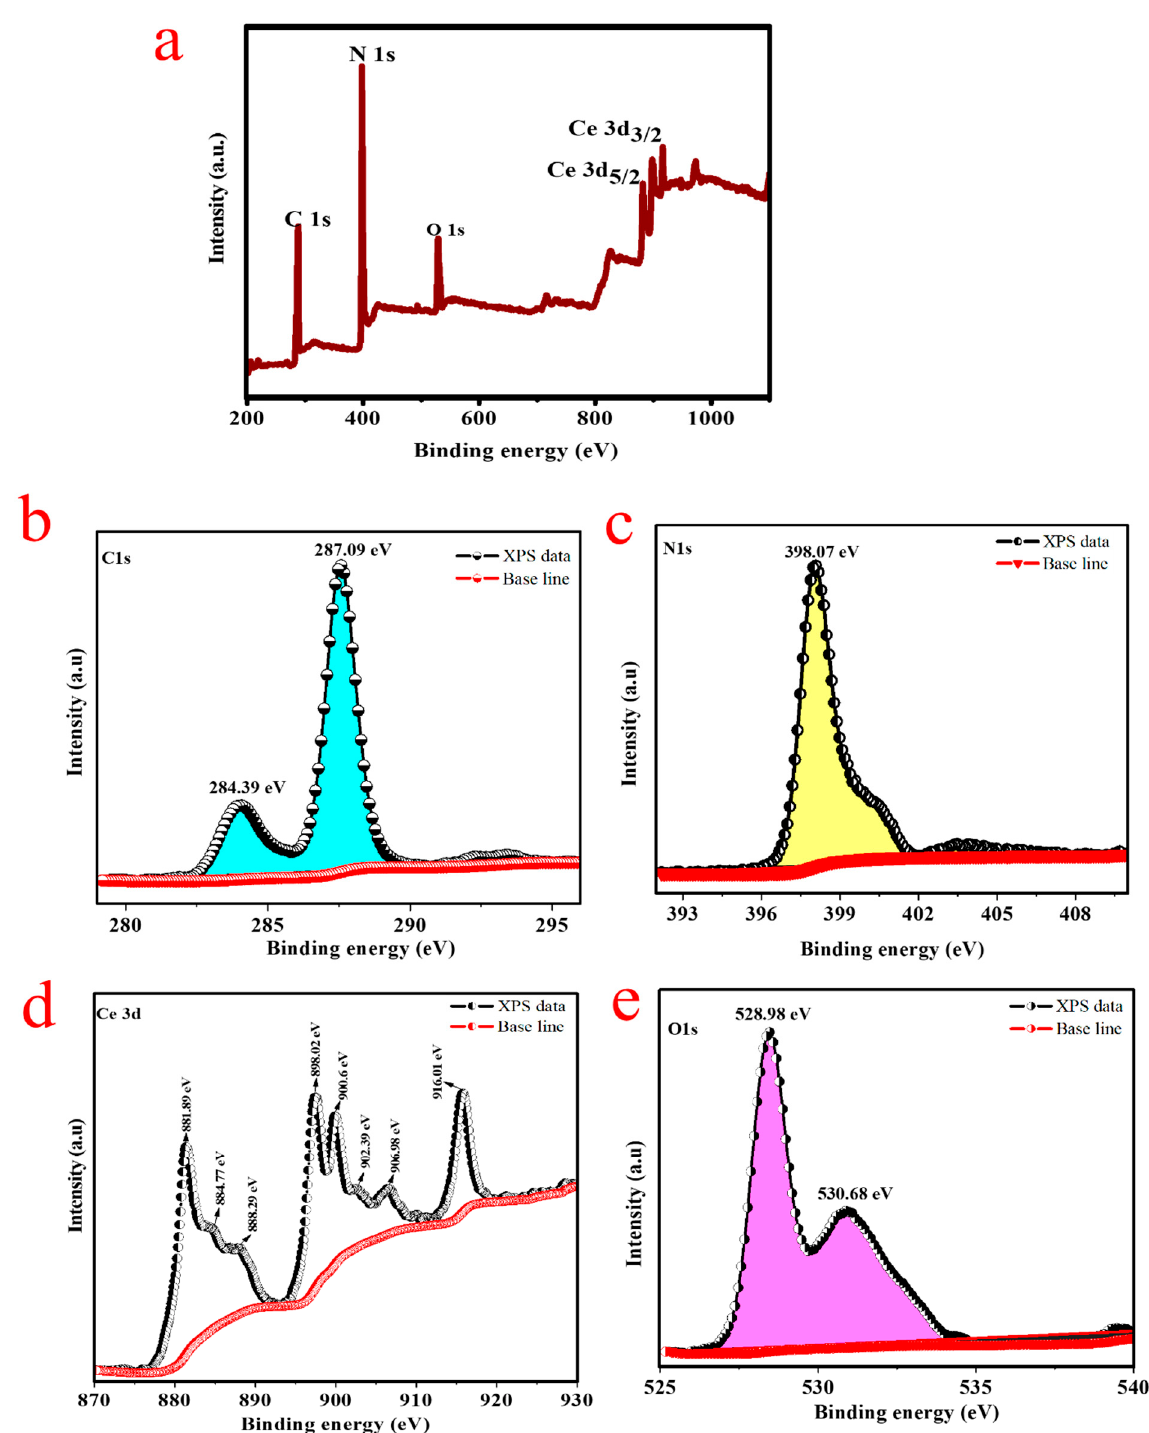
Figure 4. XPS results; ( a ) survey scan, ( b ) C1s, ( c ) N1s, ( d ) Ce3d and ( e ) O1s of CN/CeQDs-3 nanostructure.